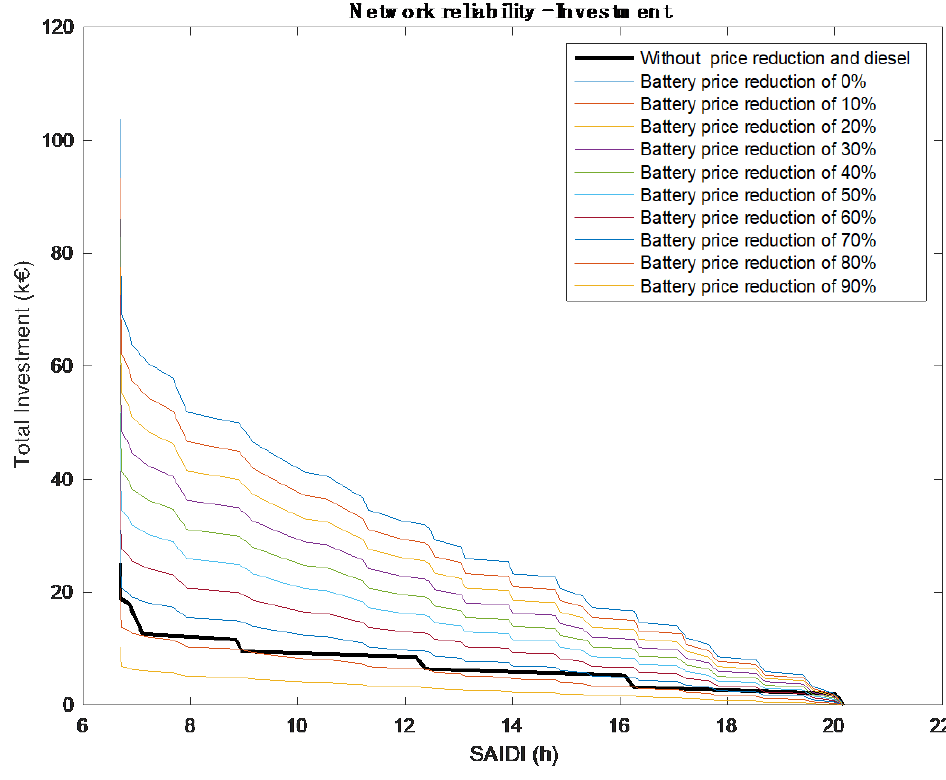
Figure 9. Pareto fronts for different battery price reductions.